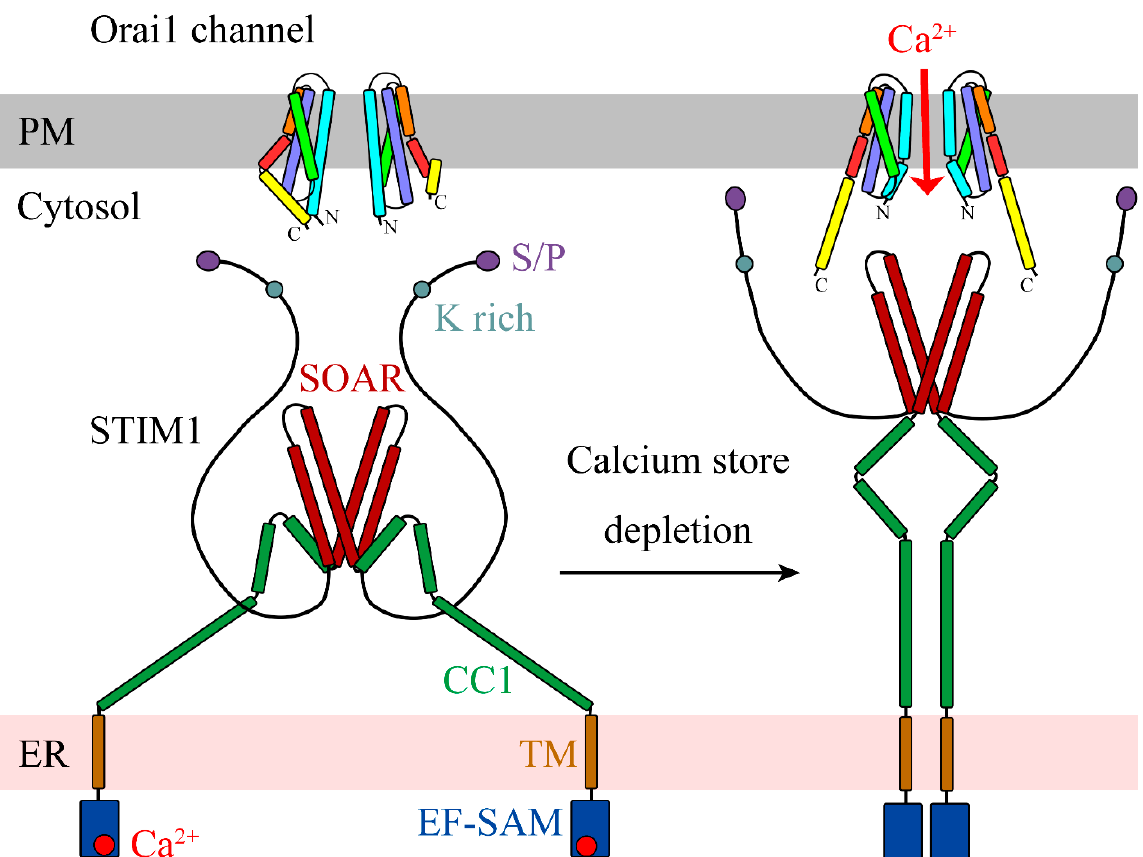
Figure 1. Diagram showing that STIM1 molecules activate Orai channels during SOCE. After ER Ca 2+ store depletion, Ca 2+ dissociates from the EF hand and the sterile alpha motif (EF-SAM) domain of STIM1. The N-terminus of STIM1 dimerizes to drive the conformational change of the CC1 region, eliciting the release of the SOAR domain. The SOAR then associates and activates the Orai channel on the PM. Finally, the open Orai1 channel allows extracellular Ca 2+ to permeate.